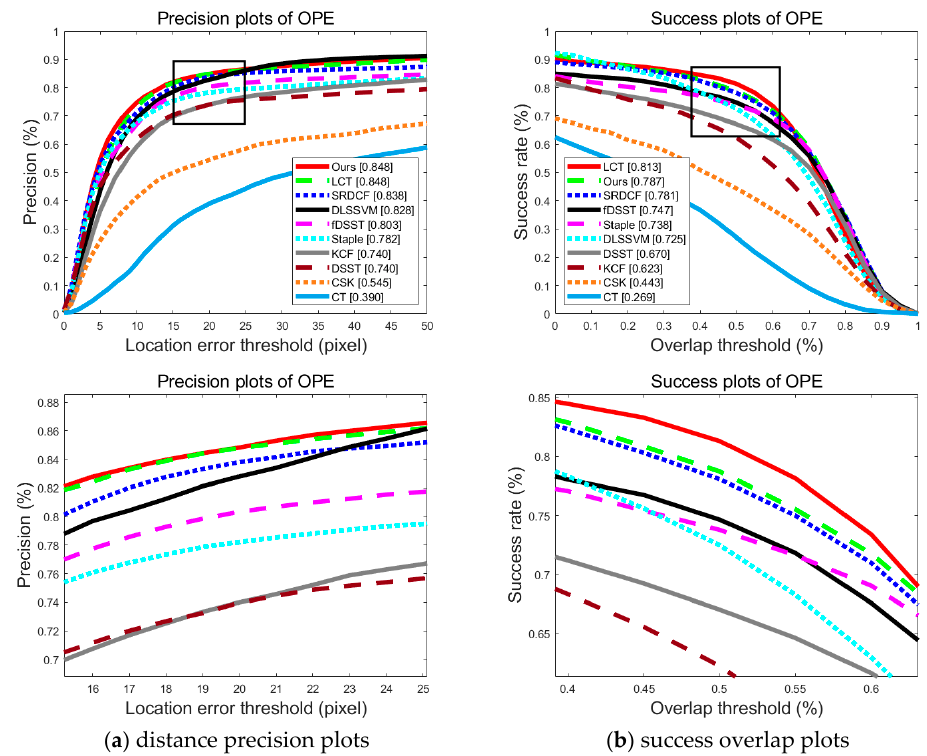
Figure 5. Precision plots and success plots of one-pass evaluation (OPE) on OTB2013 datasets. Performance within the black box is shown enlarged under the corresponding curve. Appl. Sci. 2020 , 10 , x FOR PEER REVIEW